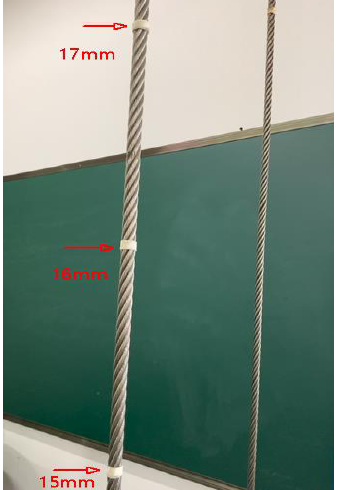
Figure 16. Obstacle negotiation ability test setup.